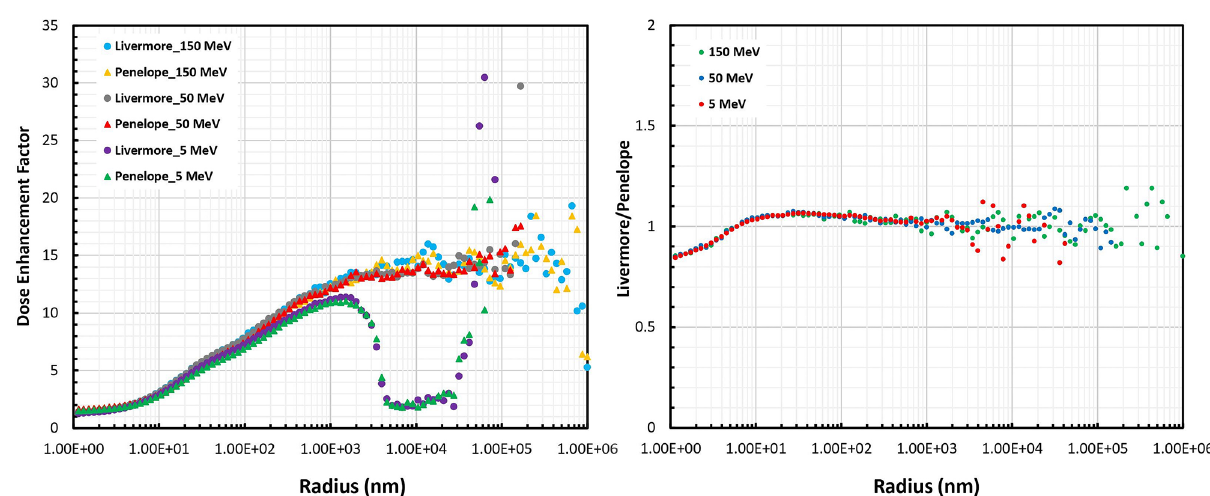
Figure 6. Comparison of the DEF between the Livermore and Penelope models obtained for 5, 50, and 150- MeV proton beams as a function of radial distance from the GNP